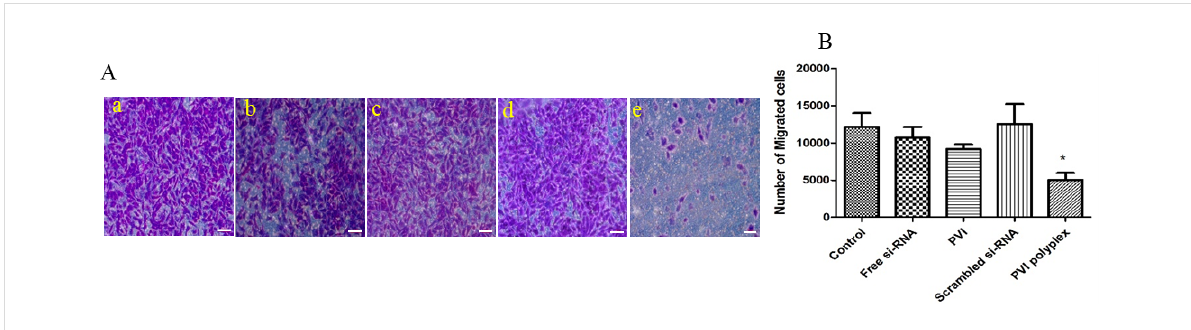
Figure 11: (A) Migration of A549 cells analyzed using Boyden chamber assay 48 h after treatment. a: Control; b: free siRNA; c: blank polymer nano- particles; d: polyplex with scrambled siRNA; e: polyplex with VEGF siRNA. VEGF silencing slows down the migration of A549 cells. The cells were stained using 0.5% crystal violet for visualization and images were taken using phase-contrast microscopy. The scale bars represent 50 μ m. (B) Migration of the A549 cells 48 h after treatment, * p < 0.05 vs control.